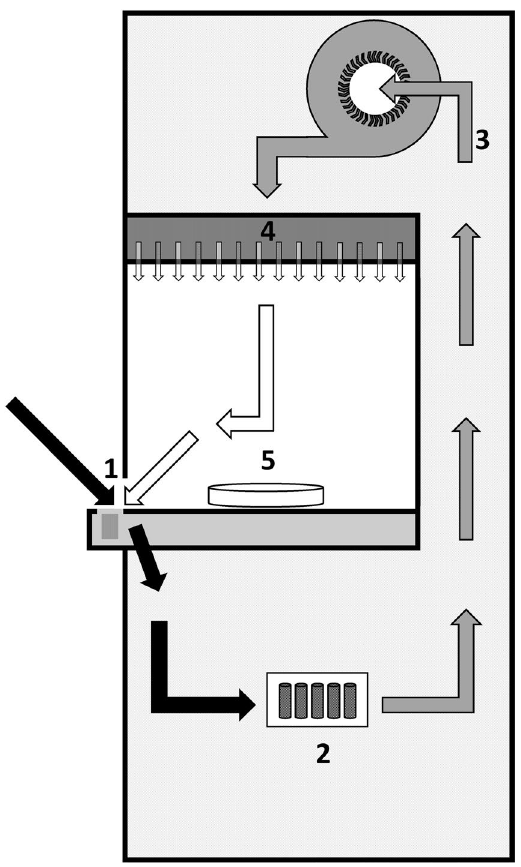
Figure 4. Image of a laboratory clean bench with particles- and activated carbon filtration. Clean benches provide a particle-filtered environment to protect samples from aerial contamination. Ambient air with floatable particles (black arrows) and filtered pure air (white arrows) are transported to suction slots (1) and passed through an activated carbon filter (2). Cleaned air is drawn by a radial fan (3) and pressed through a particle filter (Hosch-Filter) into the workspace (4). The filtered pure air flows gently (laminar flow) across the work surface over the sample (5) and towards the operator and then back into the suction slots.